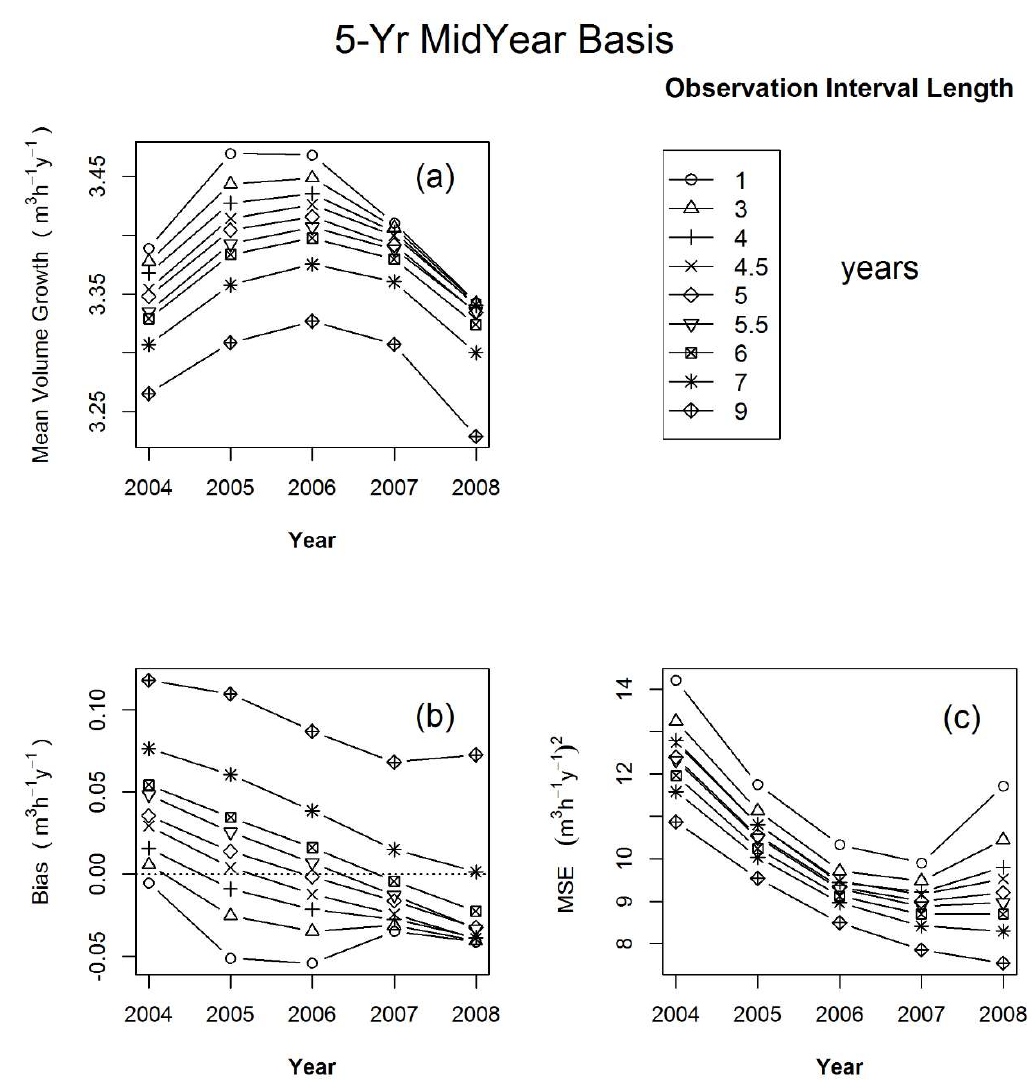
Figure 4. The simulation mean volume growth ( a ), the simulation mean bias ( b ), and the simulation mean of mean-squared errors ( c ) for Estimand 2 (the five-year centralized moving average) for the means from each of the nine interval lengths of 1, 3, 4, 4.5, 5, 5.5, 6, 7, and 9 years, applied to the years 2004–2008, from 100 samples of size 1000 from each of the 125 populations.